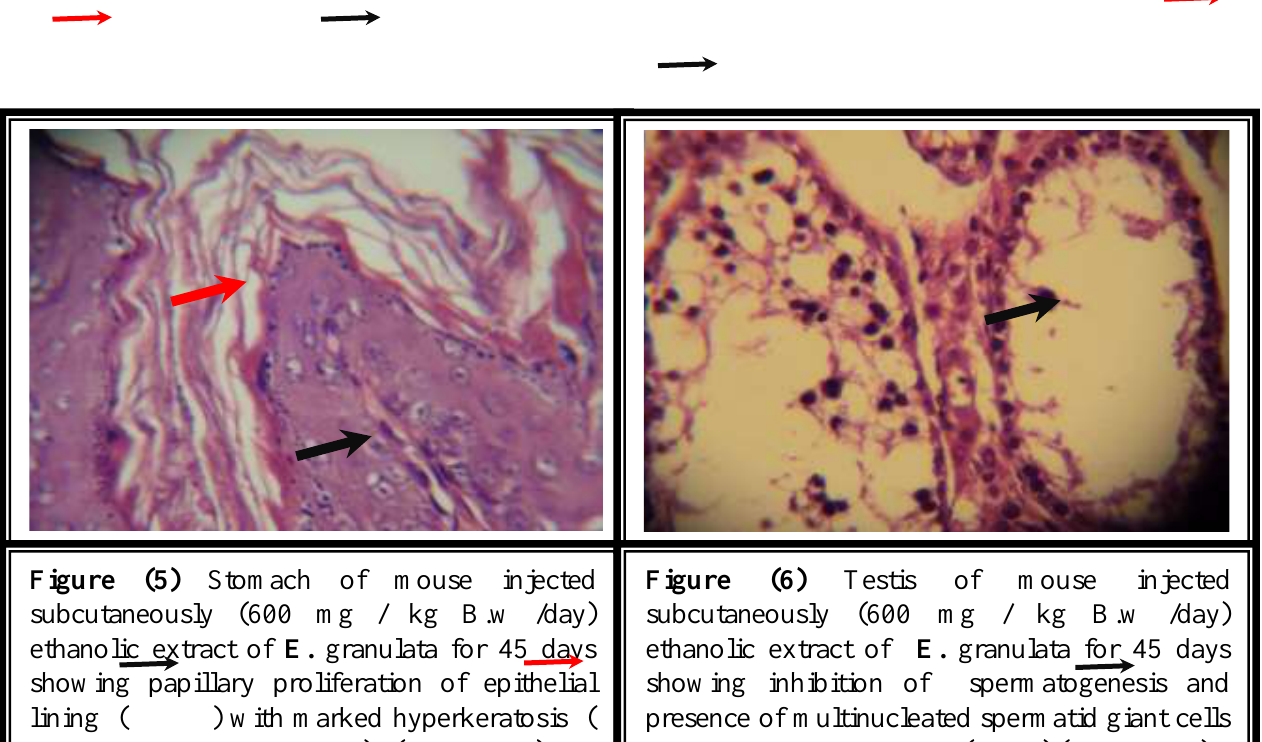
Figure (5) Stomach of mouse injected Figure (6) Testis of mouse injected subcutaneously (600 mg / kg B.w /day) subcutaneously (600 mg / kg B.w /day) ethanolic extract of E. granulata for 45 days ethanolic extract of E. granulata for 45 days showing papillary proliferation of epithelial showing inhibition of spermatogenesis and lining ( ) with marked hyperkeratosis ( presence of multinucleated spermatid giant cells ) (H&Ex 400). ( ) (H&Ex 400).